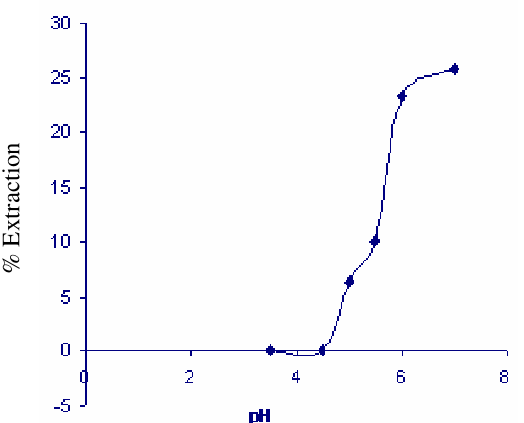
Figure 3. The effect of pH on the extraction of PHDC-copper